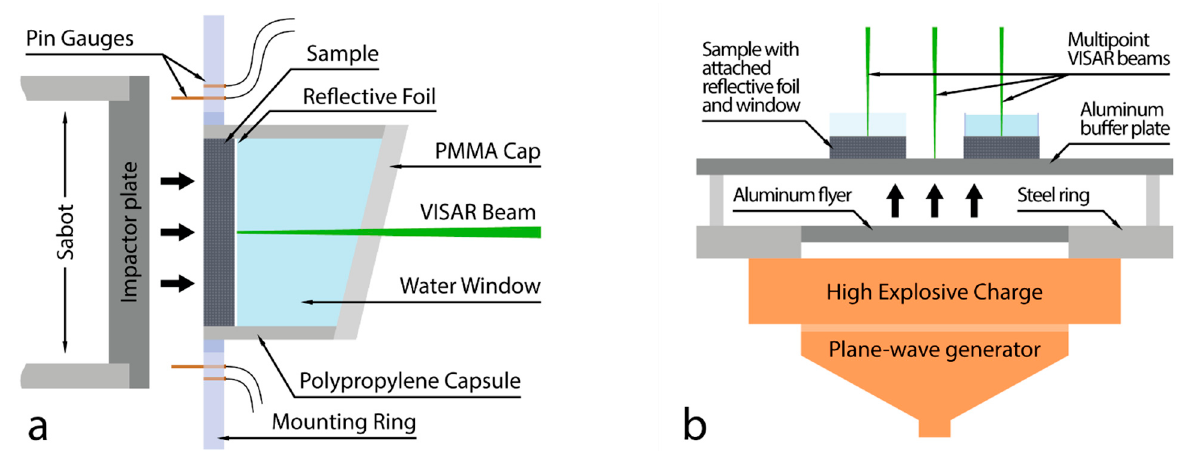
Figure 2. ( a ) Schematic of the powder gun experiment. ( b ) Schematic of the explosive charge ex- periment. Table 2. Hugoniot and wave front data for precursor.